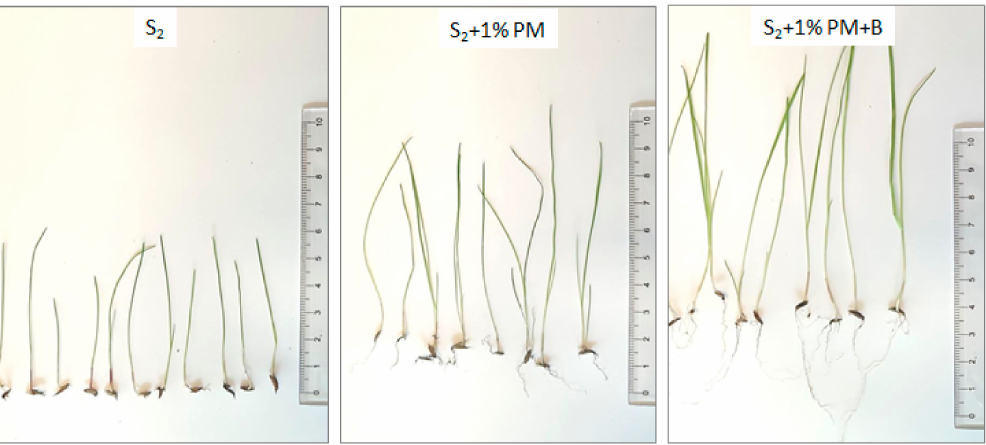
Figure 6. Impact of poultry manure treated with calcium peroxide on roots and shoots length of the grass seed